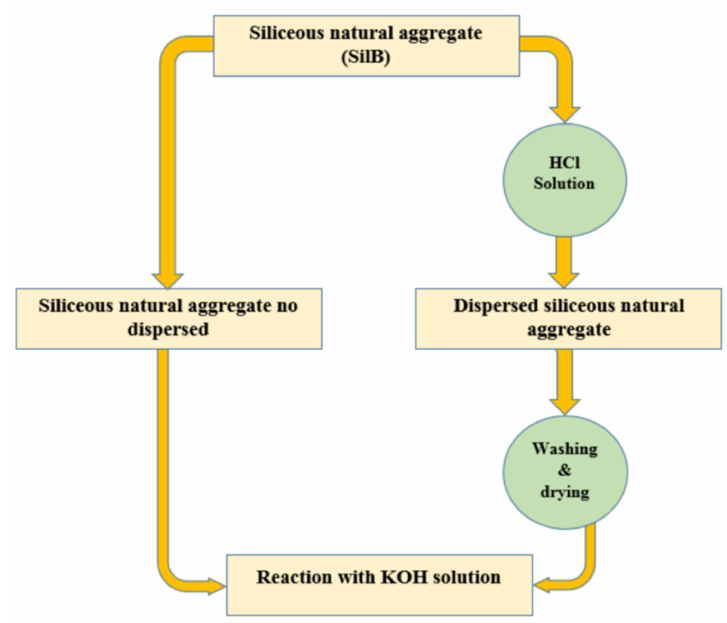
Figure 1. Preparation protocol